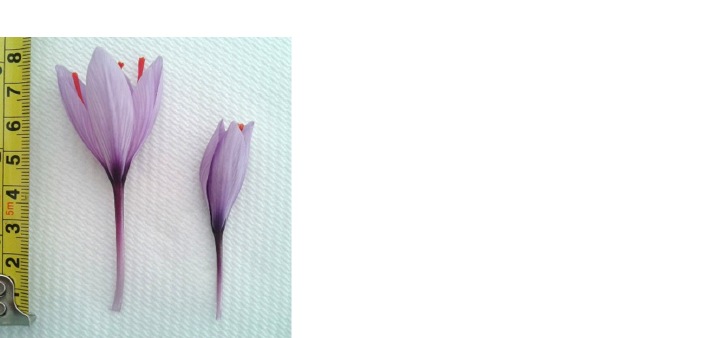
Table 4. Qualitative analysis of the saffron